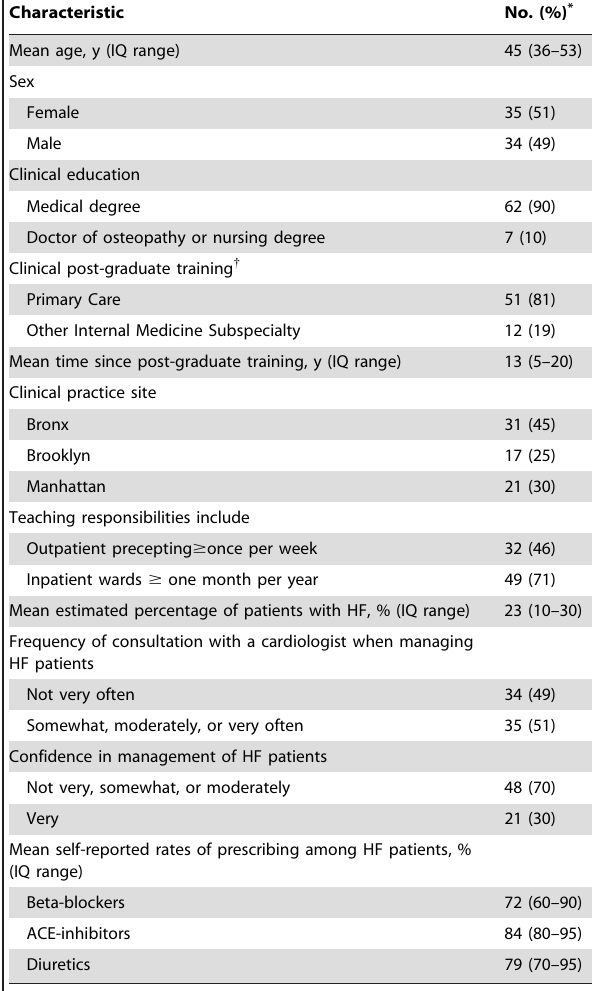
Table 1. Physician Characteristics (n=